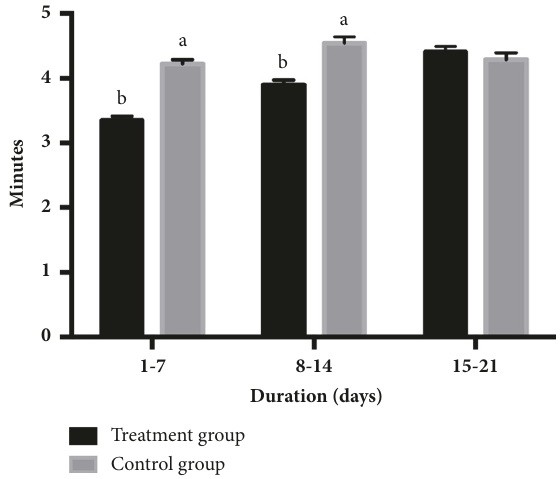
Figure 2: Comparison of onset time for the first piglet to come to the sow’s udder to suckle in the treatment group (exposed to AS sounds) and the control group (not exposed to AS sounds) in each lactating period (1-7, 8-14, and 15-21 days after parturition). a , b Statistical significance (P < 0.05) between groups.